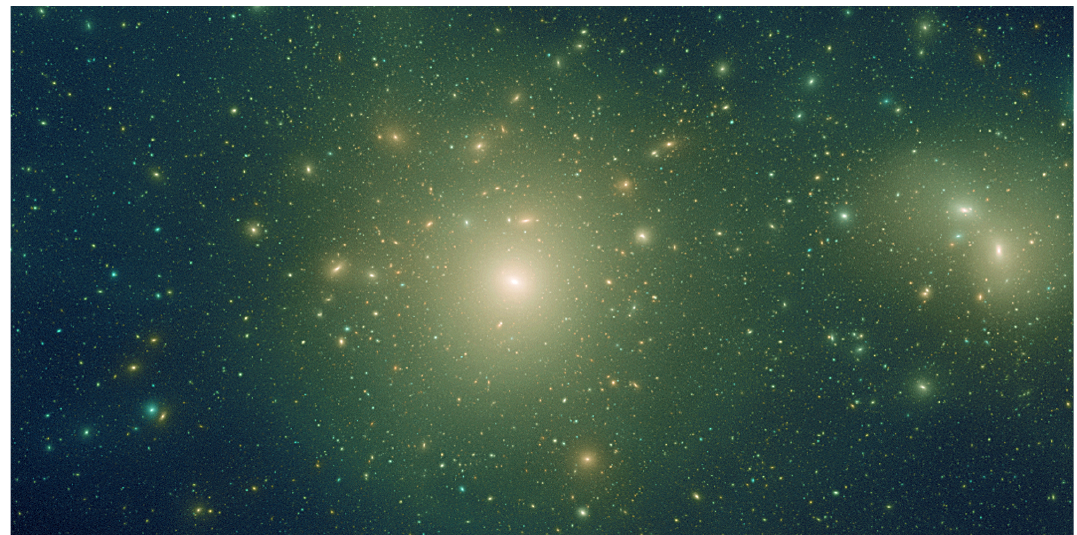
Figure 1. Dark matter distribution of a Milky-Way-size halo taken from a high-resolution cosmological N -body simulation